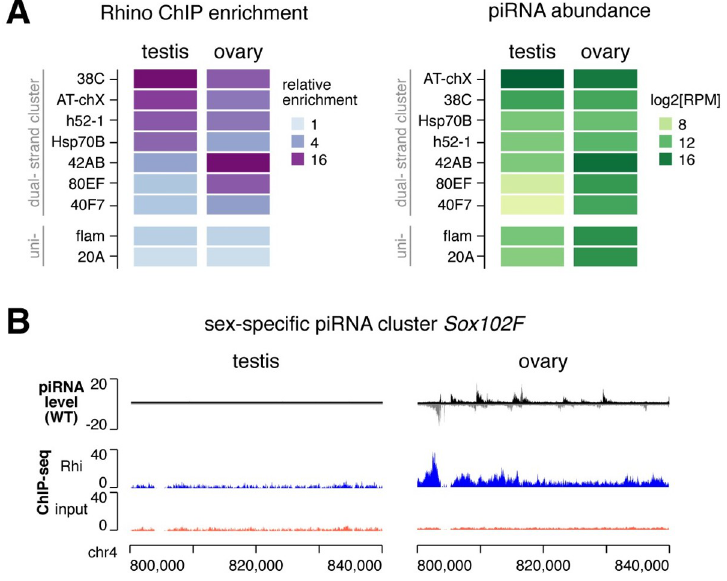
Fig 5. Sexually dimorphic RDC genome occupancy sculpts sex-specific piRNA program. (A) Heatmaps showing relative enrichment of Rhi binding over major piRNA clusters determined by ChIP-seq (left) and piRNA production from major piRNA clusters (right) in two sexes. The mean of two biological replicates is shown. Rhi-dependent dual- strand clusters are shown at the top, and Rhi-independent uni-strand clusters at the bottom. (B) Sox102F piRNA cluster produces piRNAs exclusively in ovary. Rhi is enriched on Sox102F in ovary, but not in testis. Shown is the profile from a representative replicate.